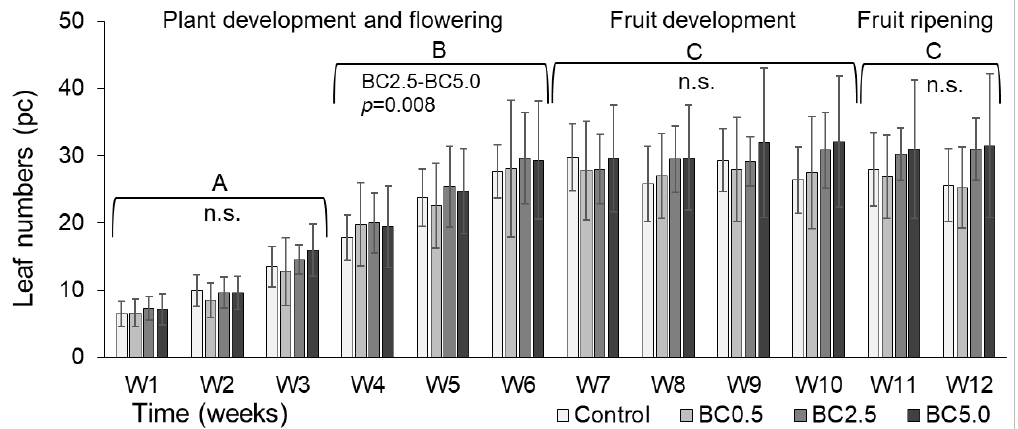
Figure 2. Overview of plant growth based on average leaf numbers (±SD) over time ( n = 8 to 14). Statistically significant differences ( p < 0.05) between growth phases are indicated by different letters; n.s. means treatments within growth phases are not significant.